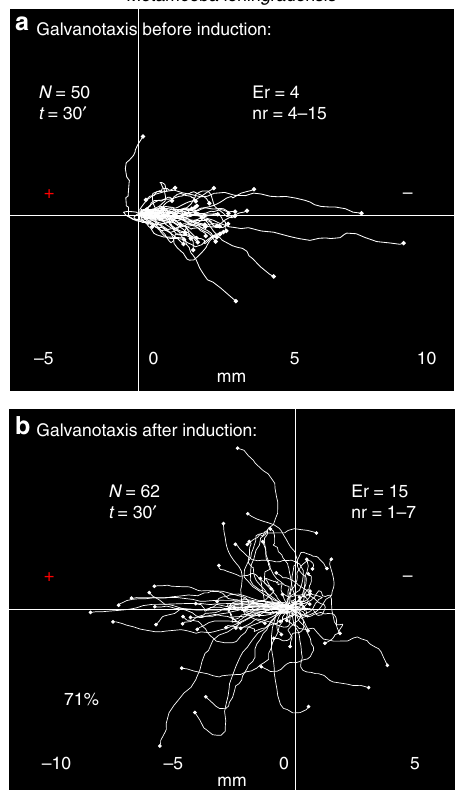
Fig. 8 Conditioning process in Metamoeba leningradensis . a Under galvanotaxis conditions practically all the Metamoeba leningrandensis migrated towards the cathode. b After induction process, the cells were placed in Chalkley ’ s medium without any stimulus for 5 min, and then they were exposed to galvanotaxis for 30 min. 71% of the induced cells presented lasting directionality towards the anode, where the chemotactic peptide was absent. “ N ” total number of cells, “ Er ” experimental replicates, “ nr ” number of cells per replicate, “ t ” time of galvanotaxis or chemotaxis, “ + ” anode, “ − ” cathode. Both the x and y axis show the distance in mm, and the initial location of each cell has been placed at the center of the diagram